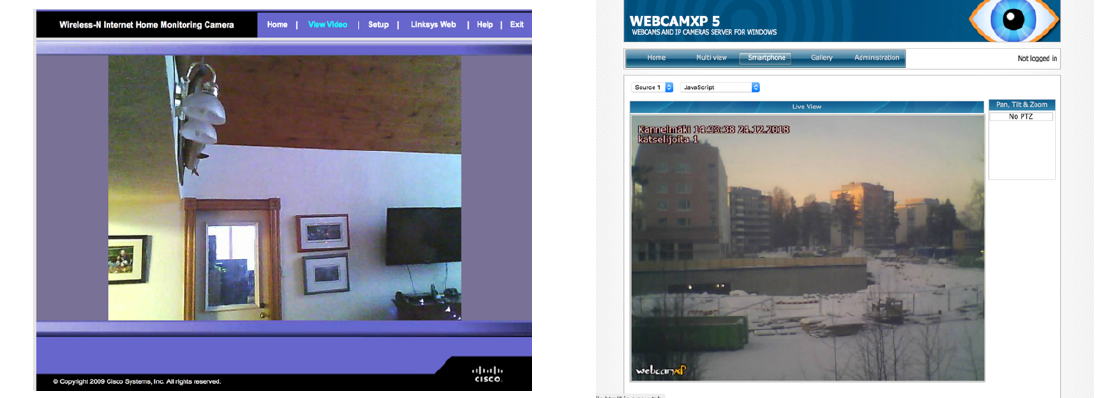
Figure 9. Screenshots of open WVC80N (left) and WebcamXP (right) webcams found with Shodan.